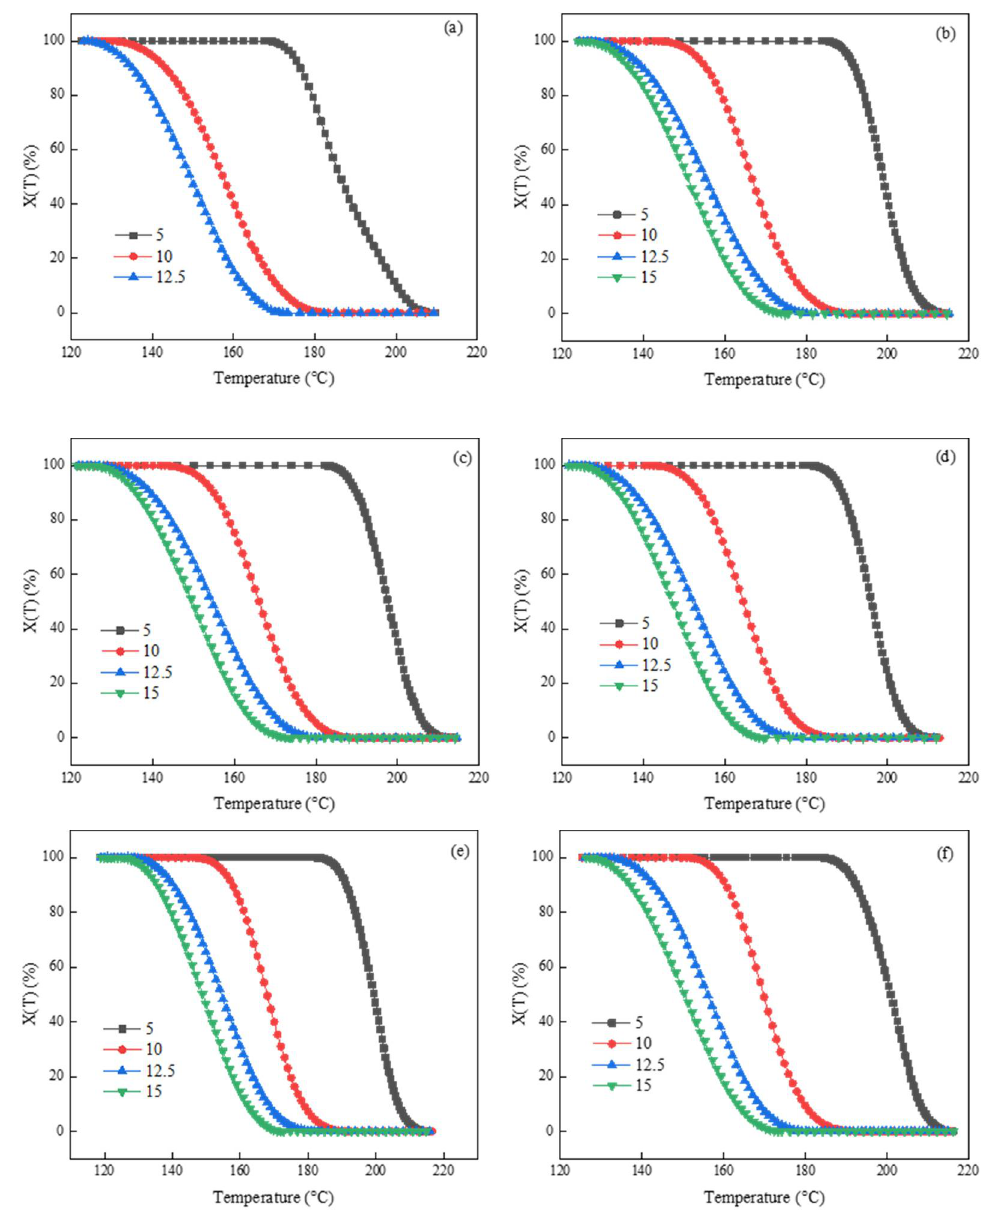
Figure 2. X(T)-T curves of PET. ( a ) PET; ( b ) PSLDH 0.01 wt%; ( c ) PSLDH 0.03 wt%; ( d ) PSLDH 0.05 wt%; ( e ) PSLDH 0.07 wt%; ( f ) PSLDH 0.1